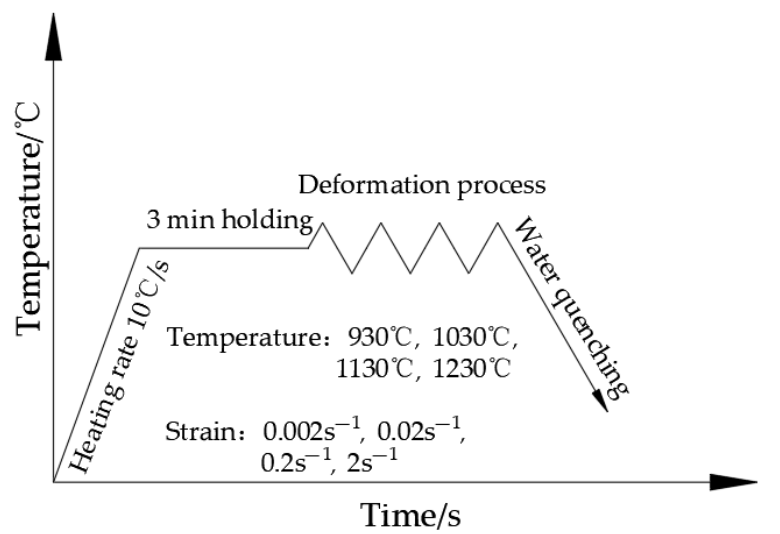
Figure 1. Temperature curve of hot compression